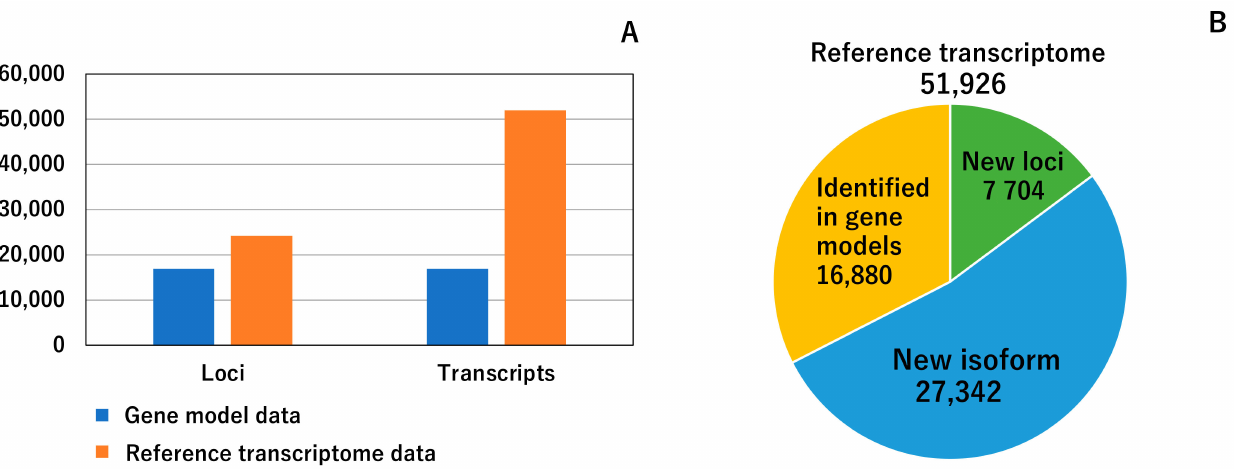
Figure 3. Basal characteristics of the reference transcriptome. ( A ) Comparison of the gene model data [15] and the reference transcriptome data of the present study. The numbers of the loci and transcripts are shown. These numbers were calculated from gff files of the two data sets. ( B ) Classification of 51,926 transcripts. Each transcript was classified into three categories, and the numbers of the three categories are shown in a pie chart. Definitions of the three categories are described in the main